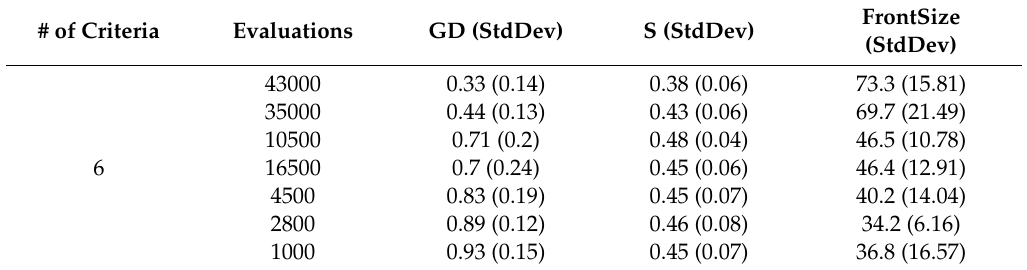
Table A5. IMGAMO results for DTZ2 six-criteria problem for di ff erent values of function evaluations.